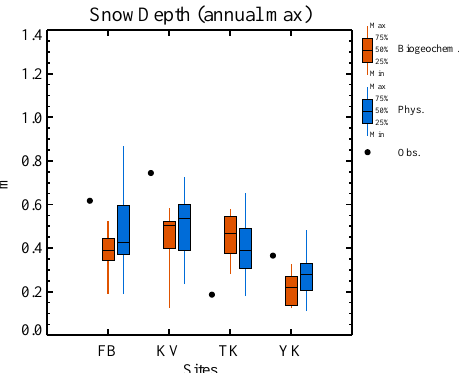
Figure 6. As for Fig. 3, except the plot displays annual maximum snow depth. The physical models include 2LM, JULES, MATSIRO, PB-SDM, SMAP, and SNOWPACK (for FB and KVTK only). The observation shows the average values for 1980–2012, 1996–2013, 1980–2008, and 1980–2008 at FB, KV, TK, and YK, respectively.